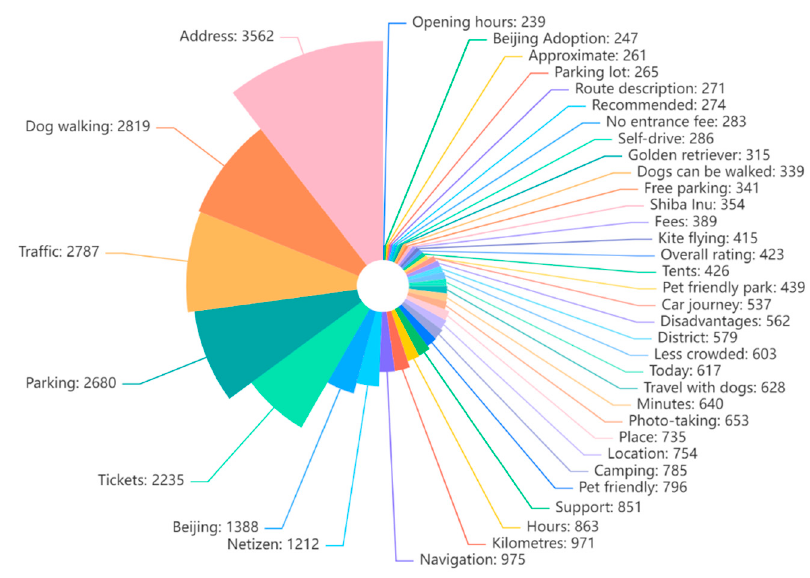
Figure 4. Word frequency rose chart (before the outbreak).